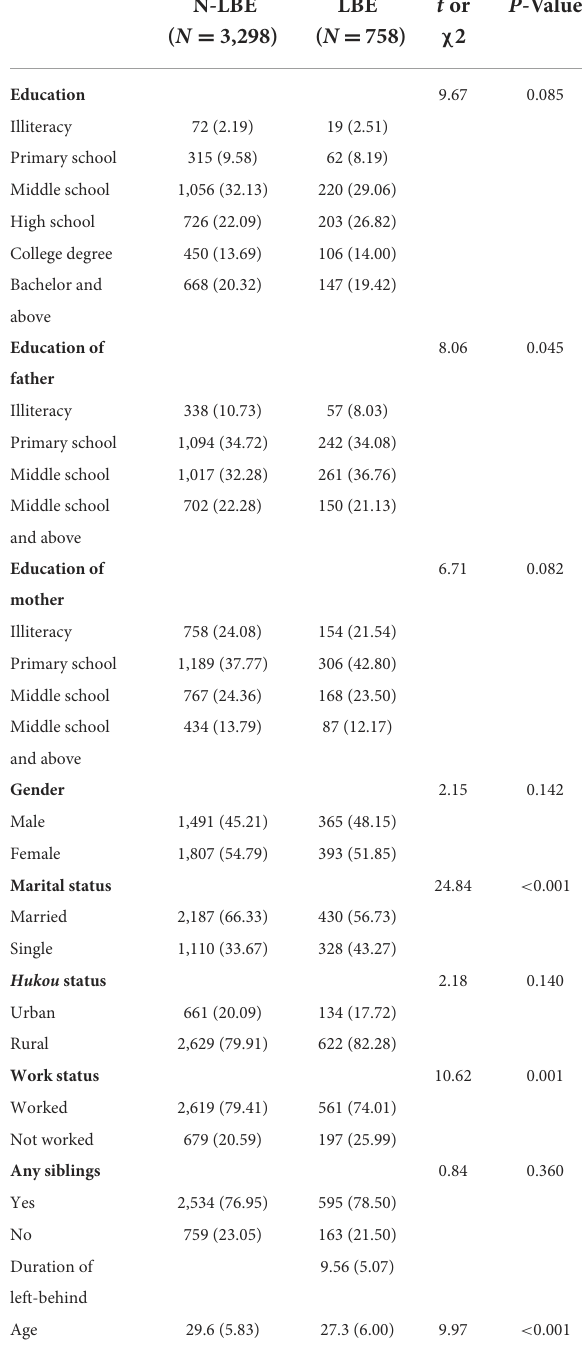
TABLE 1 Sample characteristics by left-behind experience status, N (%)/Mean